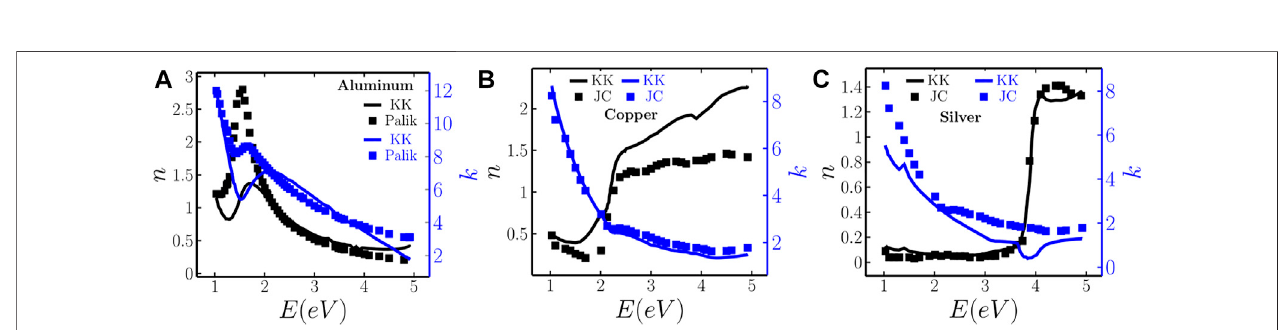
FIGURE 3 | Comparison of optical constants of pristine (A) aluminum, (B) copper, and (C) silver MTF with results of Johnson and Christy (JC) [6], and Palik [26]. Black and blue solid lines represent the real and imaginary parts of the refractive index obtained from KK analysis and the respective solid squares represent the data of Palik for Al and JC for copper and